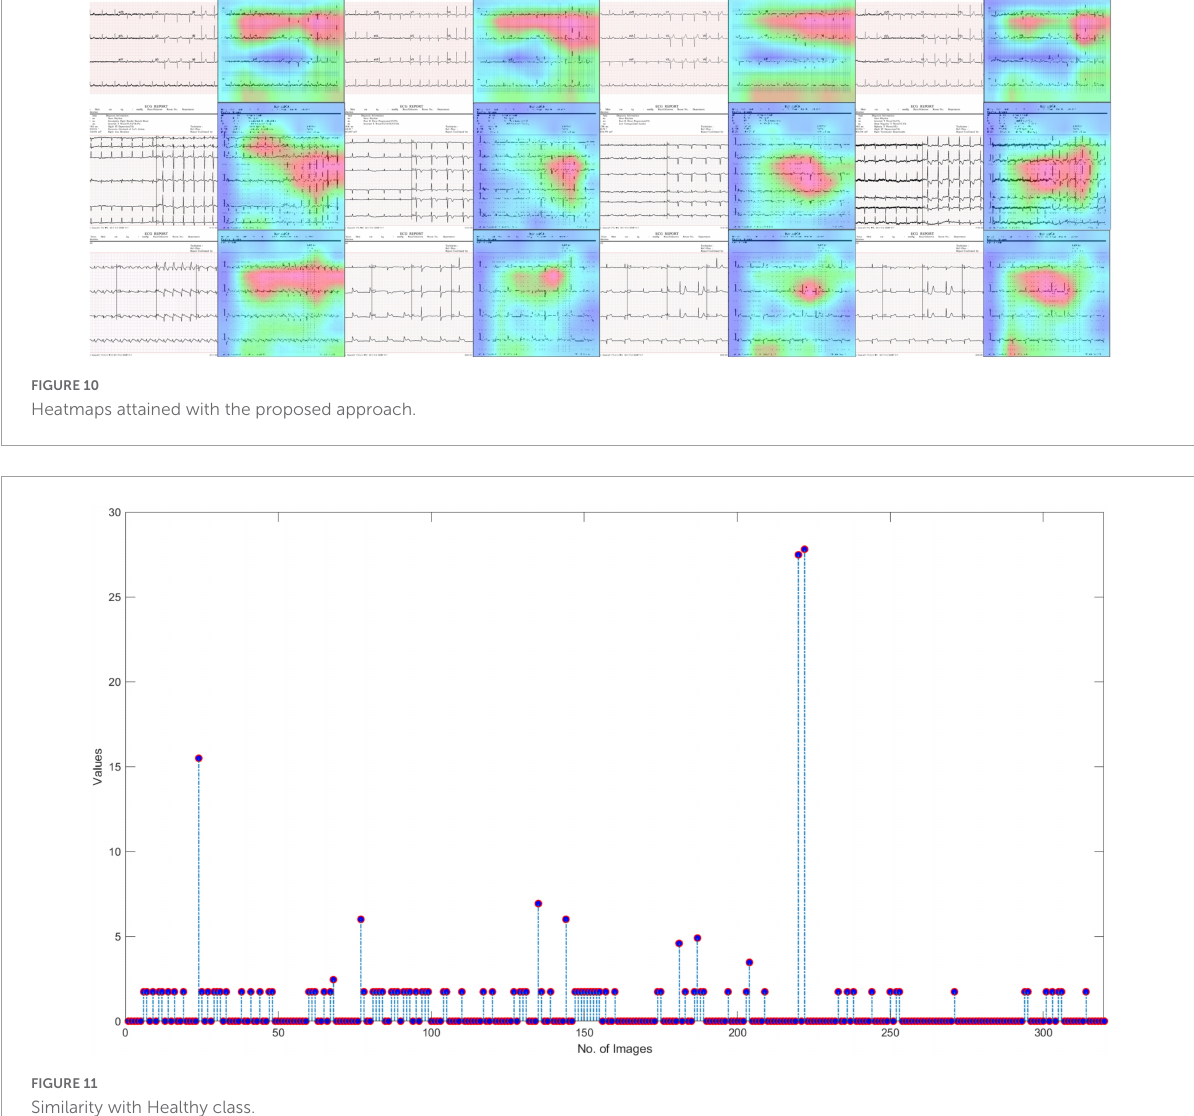
FIGURE11 Similarity with Healthy